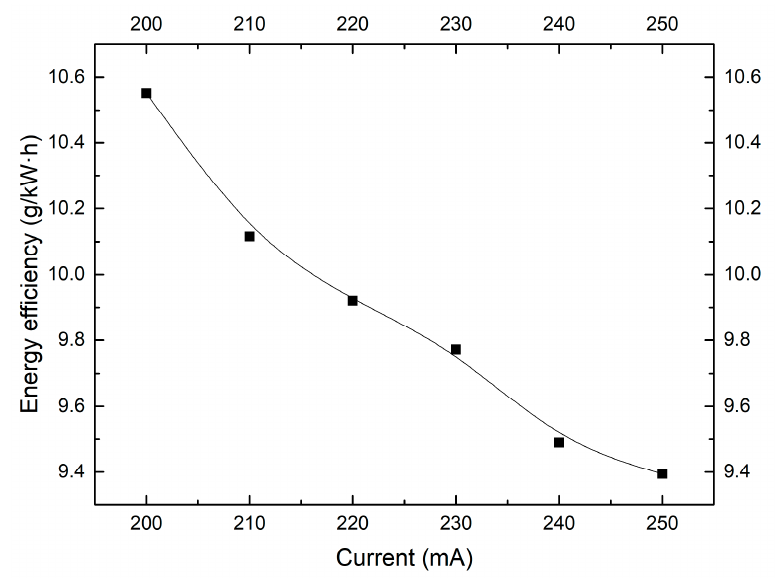
Figure 14. Effect of discharge current on the energy efficiency.